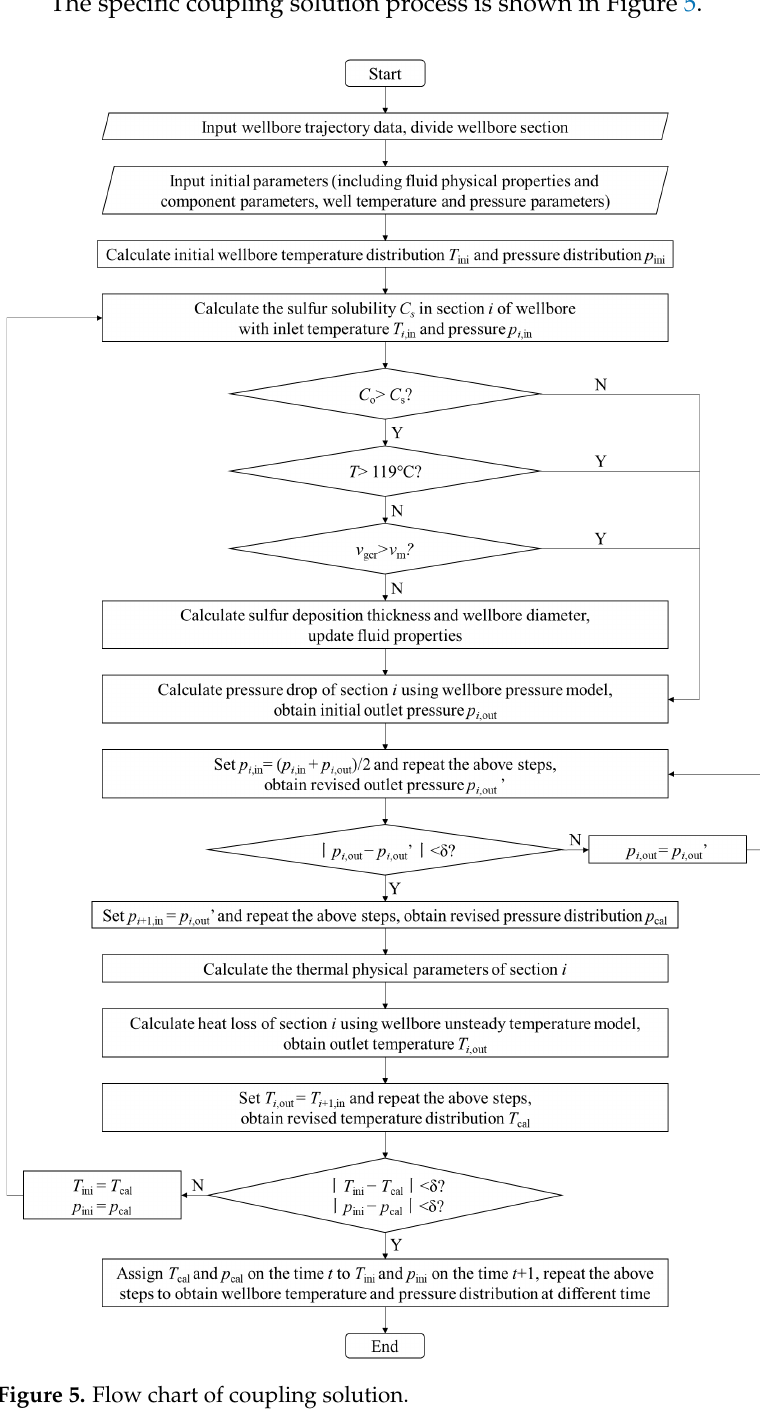
Figure 5. Flow chart of coupling solution.